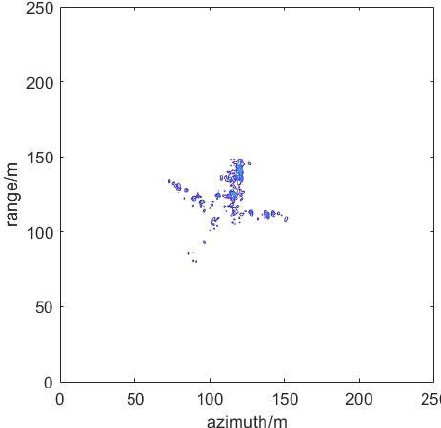
Figure 12. ISAR imaging of Yak ‐ 42.